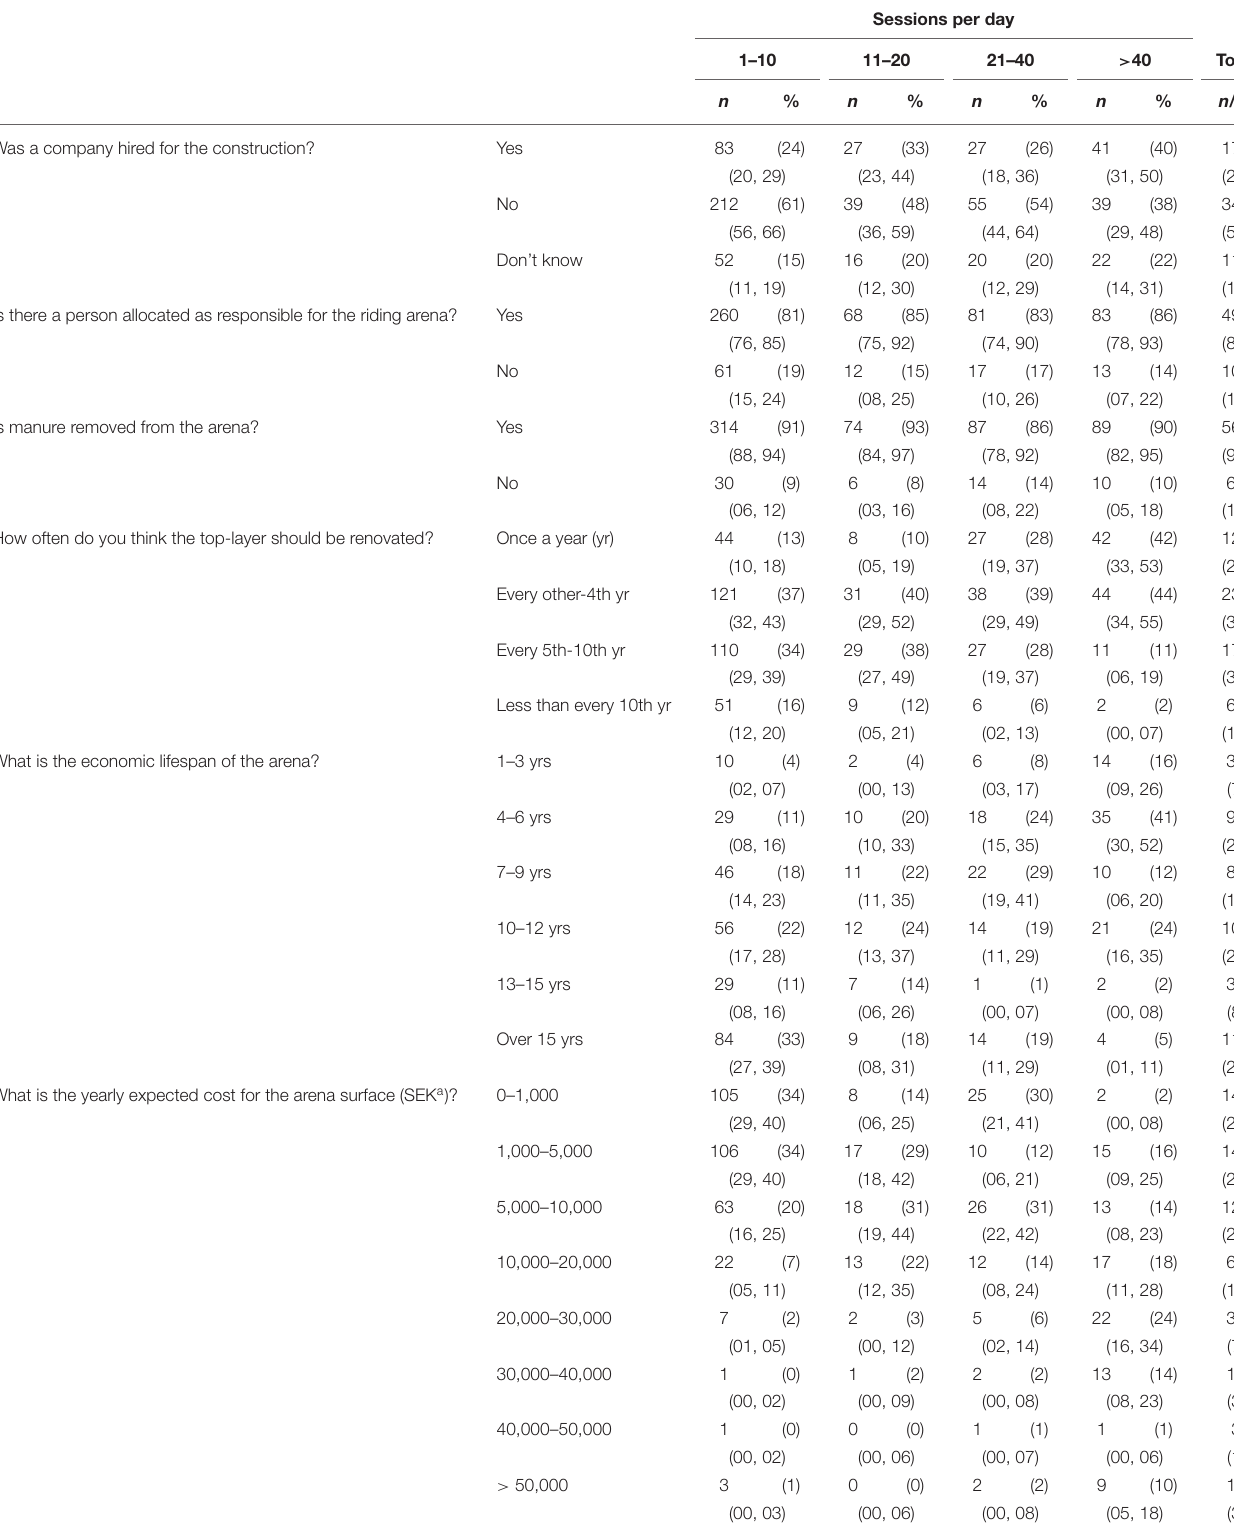
TABLE 9 | Selected questions contrasted to questions on usage